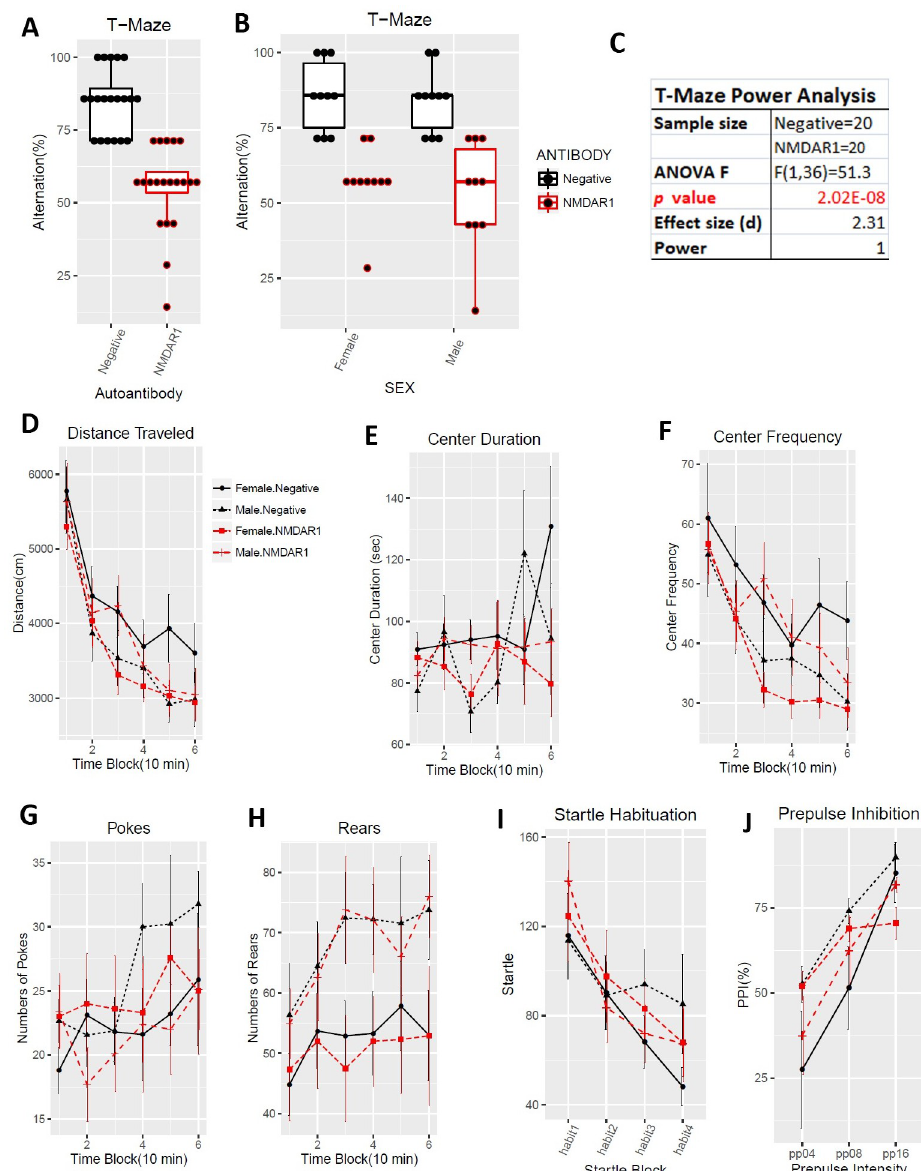
Fig 9. Replication of deficient spontaneous alternation in T-maze. All mice are healthy. (A) Alternation percentages of individual mice were present as boxplots. Spontaneous alternation was dramatically impaired in mice carrying the anti-NMDAR1 autoantibodies (F(1,36) = 51.3, p = 2.02E-08), replicating our finding across all 3 different mouse cohorts. (B) Both male and female mice carrying the anti-NMDAR1 autoantibodies displayed impaired spontaneous alternation, replicating the T-maze performance of the previous cohorts. (C) This large replication cohort of mice provided a sufficient statistical power (1) to analyze the effect size (d = 2.31) of the anti-NMDAR1 autoantibodies between the mice with or without the anti-NMDAR1 autoantibodies. Mouse locomotion and exploratory activity were examined using Behavioral Pattern Monitor. One control mice died during the behavioral tests. (D) There is neither sex (F(1,35) = 0.092, p = 0.76) nor autoantibody (F(1,35) = 0.44, p = 0.51) effect on total distance travelled in the open field. (E) Neither sex effect (F(1,35) = 0.054, p = 0.82) nor the autoantibody effect (F(1,35) = 1.33, p = 0.26) was found for center duration between the group of mice. (F) There is neither sex (F(1,35) = 0.021, p = 0.88) nor autoantibody (F (1,35) = 0.58, p = 0.45) effect on center frequency. (G) Neither sex (F(1,35) = 0.05, p = 0.83) nor autoantibody (F(1,35) = 0.23, p = 0.63) effect on pokes in Behavioral Pattern Monitor test. (H) There is a sex effect (F(1,35) = 5.4, p = 0.025), but no autoantibody effect (F(1,35) = 0.04, p = 0.84) on rears. (I) There is no sex (F(1,35) = 0.17, p = 0.68) or autoantibody (F(1,35) = 0.09, p = 0.77) effect on startle habituation. No interactions between startle block and the autoantibody (F(3,105) = 1.1, p = 0.35) was observed. (J) Neither sex (F(1,35) = 1.45, p = 0.24) nor autoantibody (F (1,35) = 0.03, p = 0.87) effect was observed in PPI. All data are present as